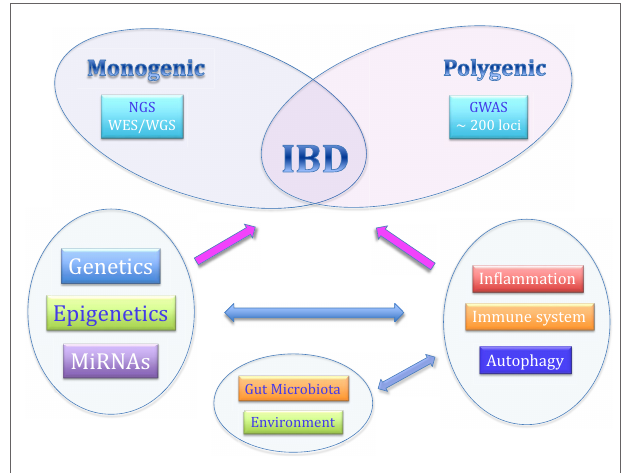
FiGURe 1 | The complex pathogenesis of inflammatory bowel diseases